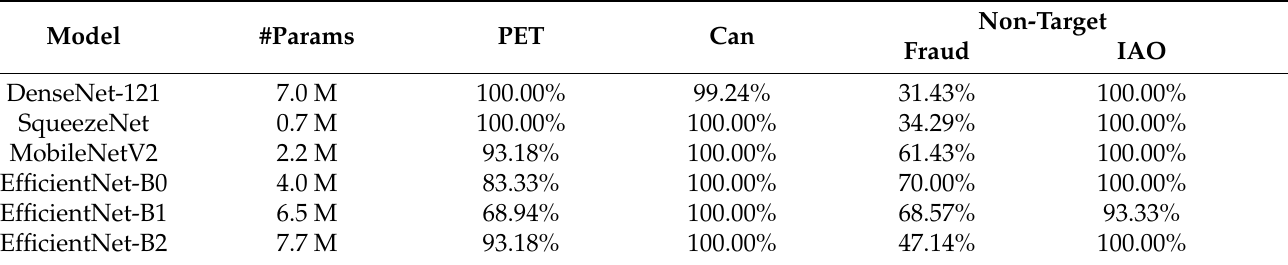
Table 5. Performance of CNNs trained with front view data, classifying objects into PET, Can, and Non-target classes.